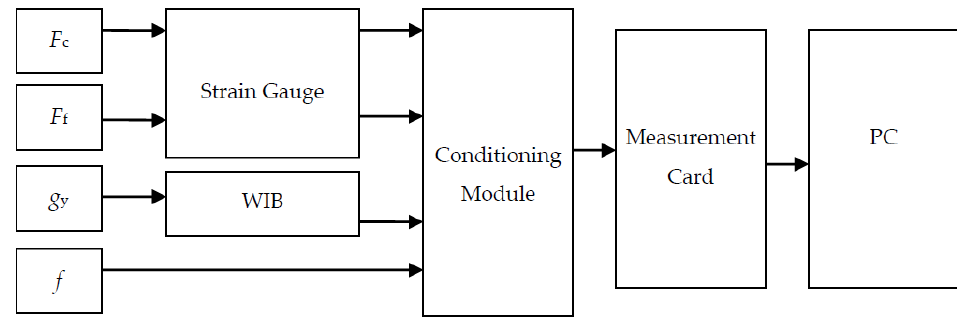
Figure 3. Schematic of the measurement chains. 145 Figure 4. Schematic of the measurement